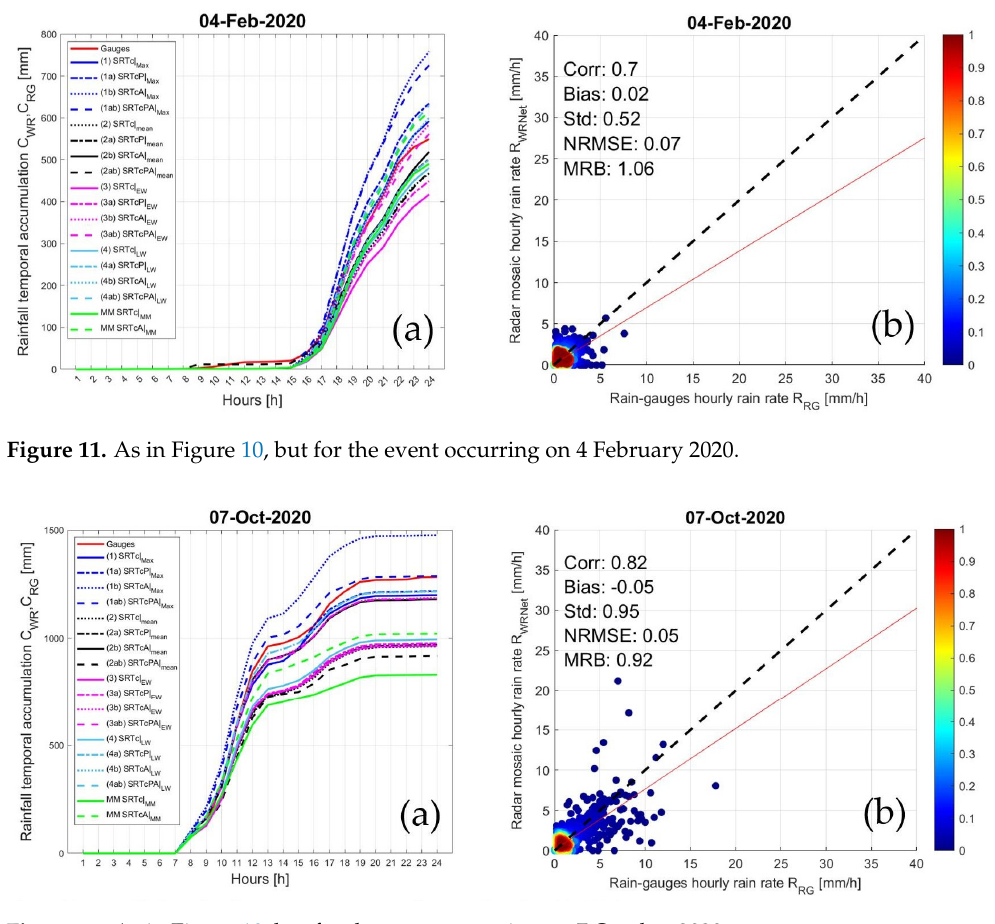
Figure 12. As in Figure 10, but for the event occurring on 7 October 2020.